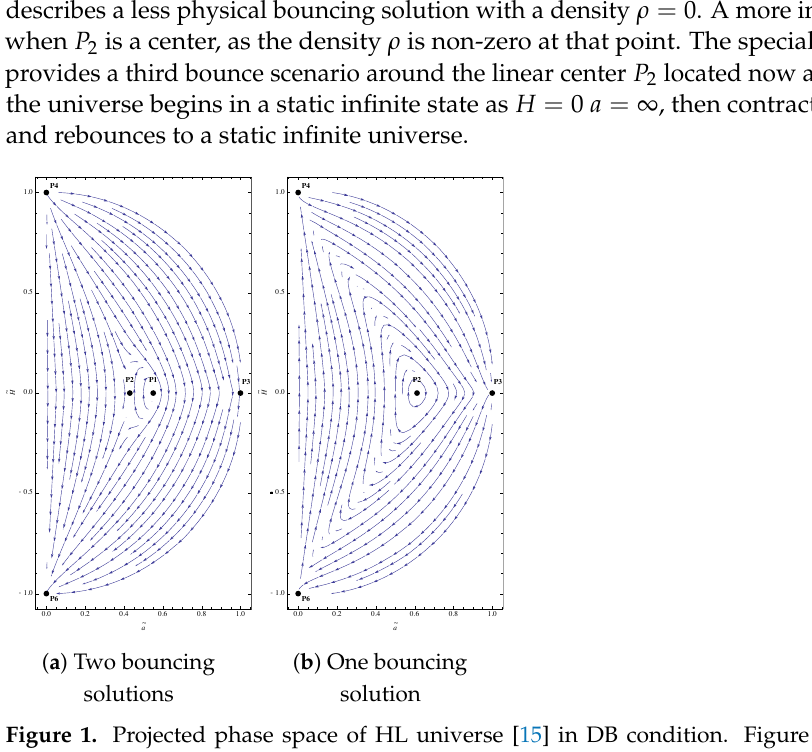
Figure 1. Projected phase space of HL universe [15] in DB condition. Figure ( a ) is the case of K / Λ E > 0 and w > 1/3. Figure ( b ), K / Λ E < 0, and − 1 < w <